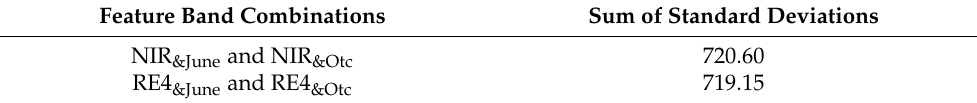
Table 2. Sum of standard deviations of feature band combinations for Quercus wutaishanica . Feature Band Combinations